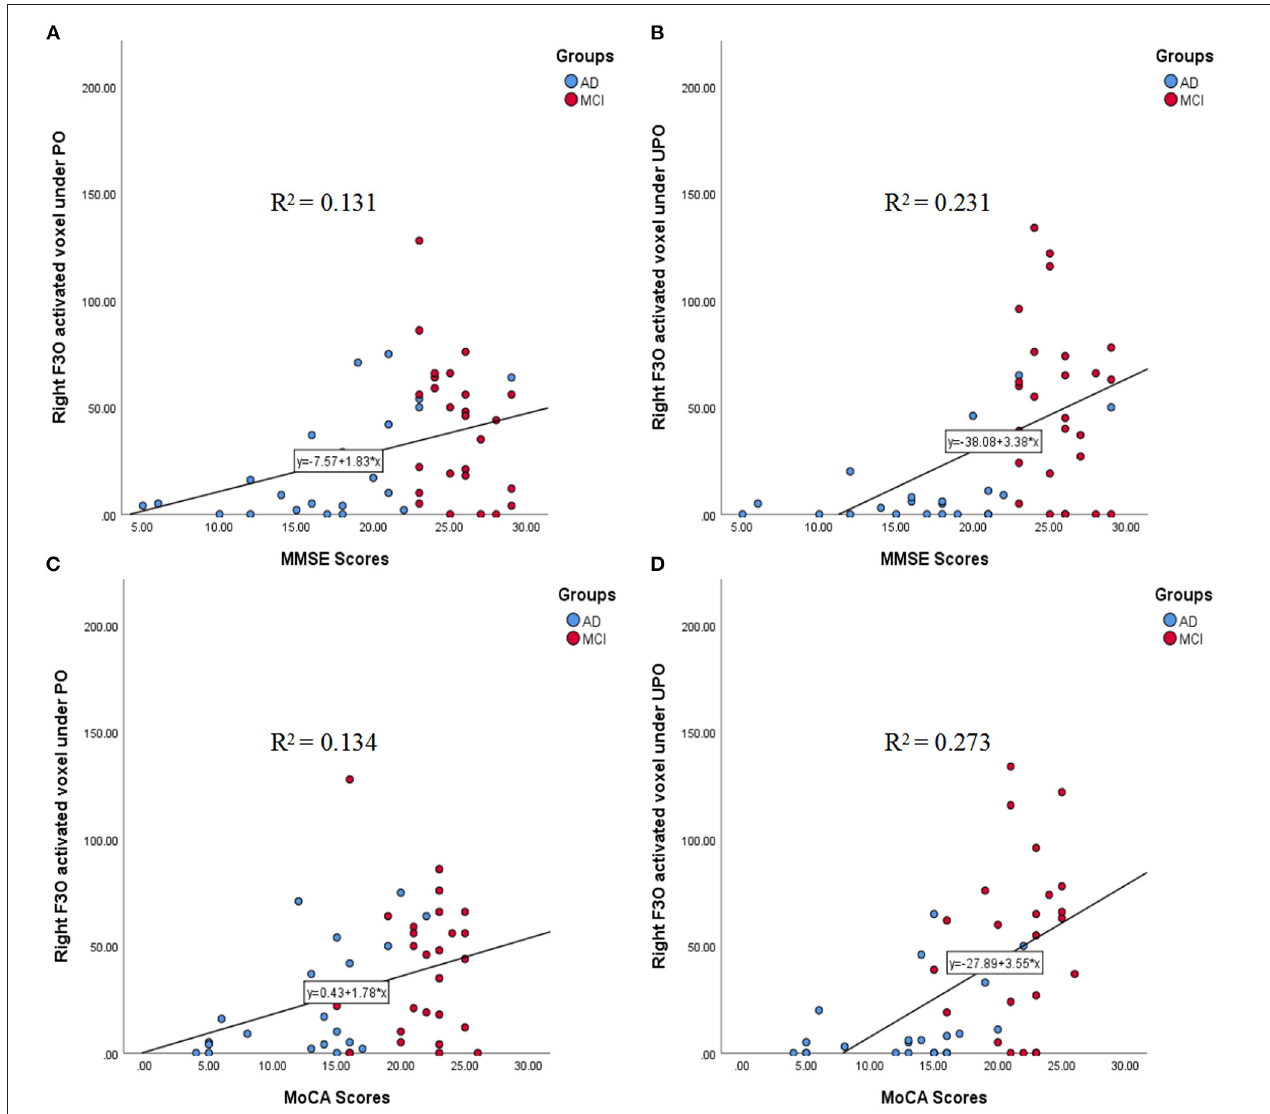
FIGURE 7 | (A–D) The correlations between the number of activated voxels in the right F3O and the MMSE and MoCA scores in the PO and UPO conditions. (A) There was a significant correlation between the number of right F3O activated voxels and the MMSE scores under PO ( r = 0.363, p = 0.010). (B) There was a significant correlation between the number of right F3O activated voxels and the MMSE scores under UPO ( r = 0.480, p = 0.000). (C) There was a significant correlation between the number of right F3O activated voxels and the MoCA scores under PO ( r = 0.298, p = 0.037). (D) There was a significant correlation between the number of right F3O activated voxels and the MoCA scores under UPO ( r = 0.460, p =